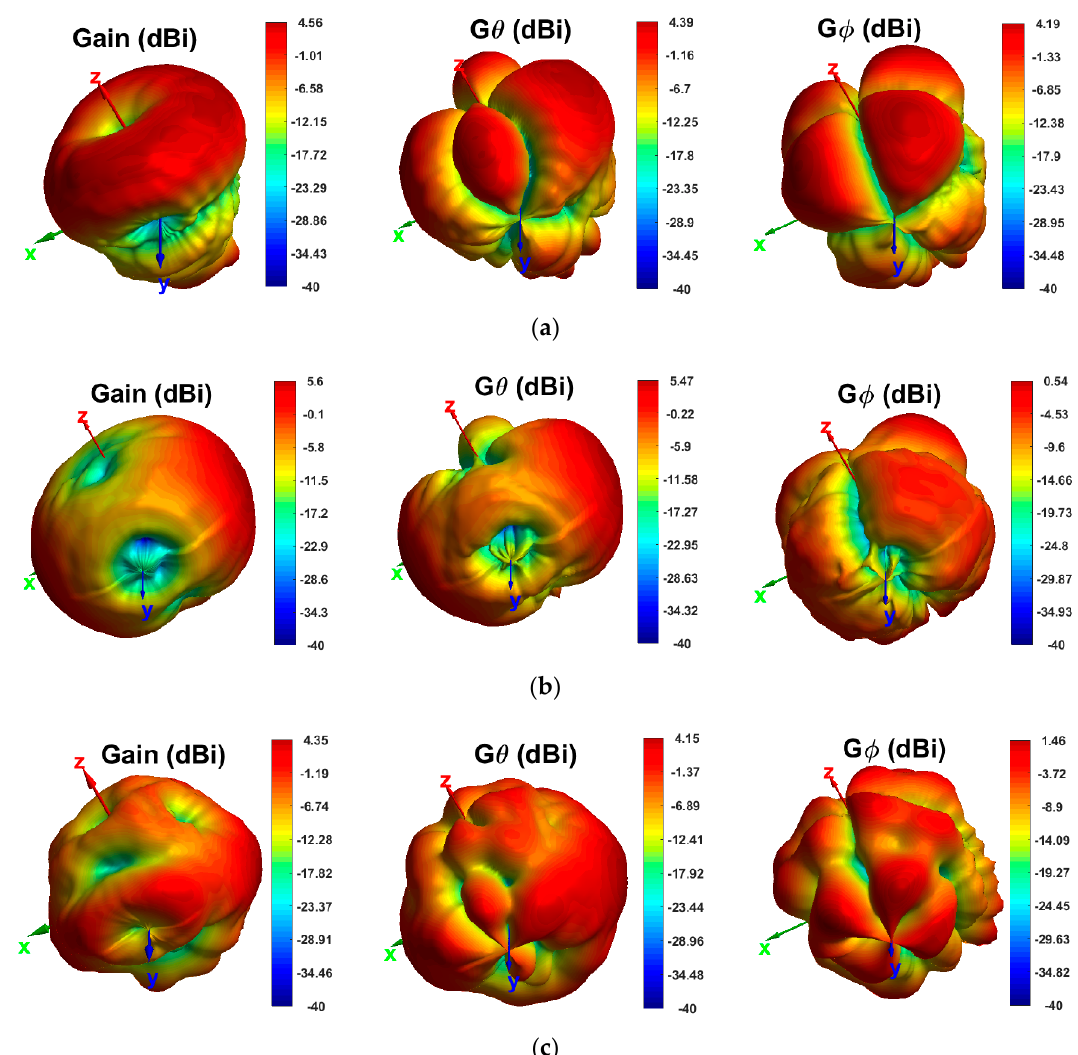
Figure 22. Measured 3D total, θ -polarized and ϕ -polarized gains at 4.4 GHz for: ( a ) single-port antenna; ( b ) two-port antenna; and ( c ) four-port antenna. Sensors 2020 , 20 ,